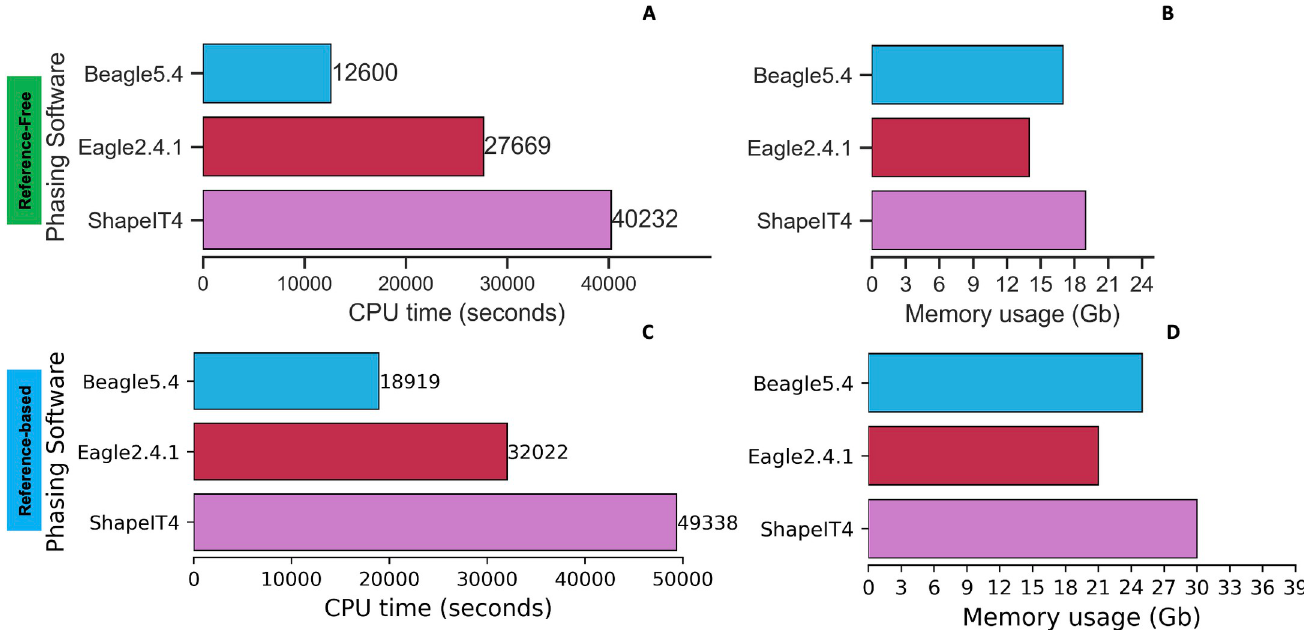
Fig 8. CPU run time and memory usage of phasing software in EBB WGS dataset. ShapeIT CPU time and memory usage are higher with a bigger input data of variants and individuals. (8A-8B) highlights a reference-free approach while (8C-8D) a reference-based approach.